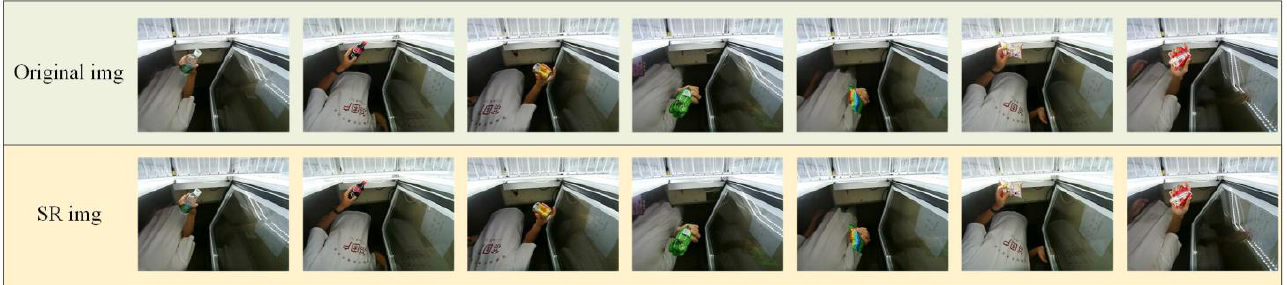
Figure 11. Comparison of original images and SR-processed images.